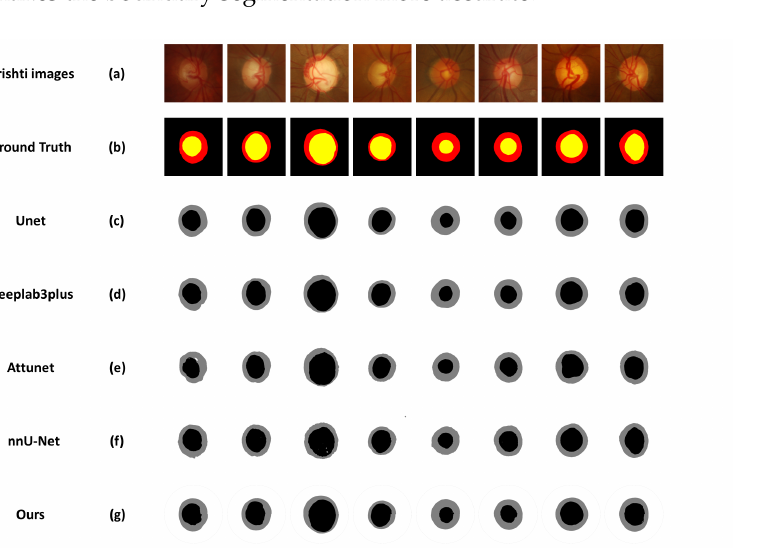
Figure 6. Visualization of OD and OC segmentation results on the DRISHTI-GS dataset. From top to bottom: ( a ) DRISHTI-GS images. ( b ) The ground truth. ( c ) The segmentation results of U-Net. ( d ) The segmentation results of DeepLabV3+. ( e ) The segmentation results of AttU-Net. ( f ) The segmentation results of nnU-Net. ( g ) The segmentation results of our